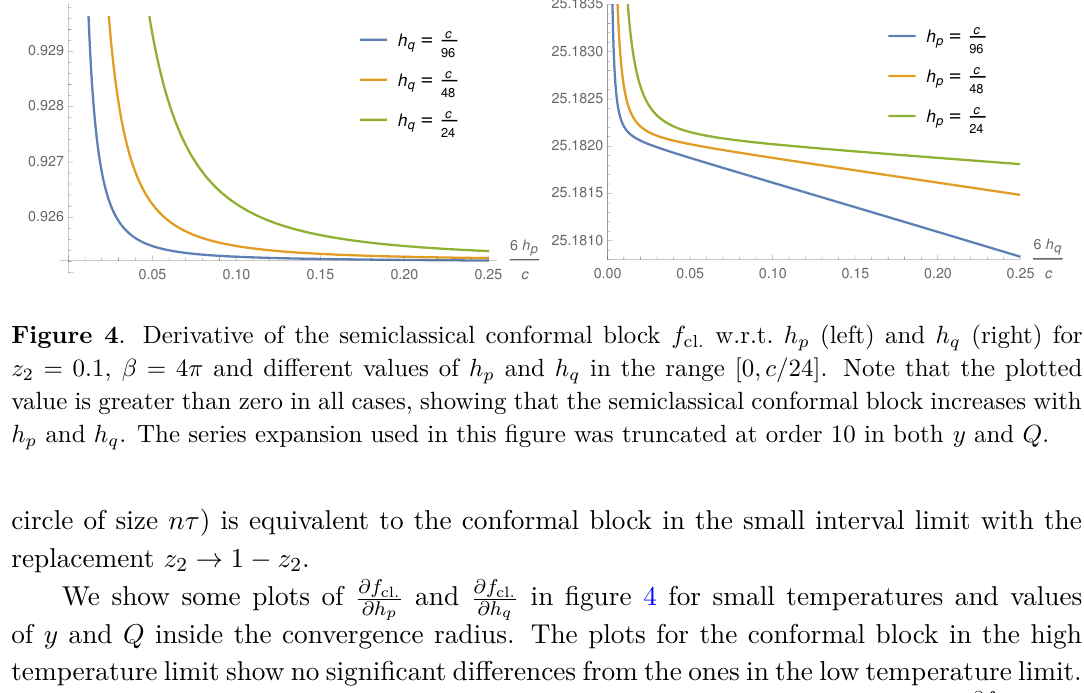
circle of size nτ ) is equivalent to the conformal block in the small interval limit with the replacement z → 1 − z 2 2